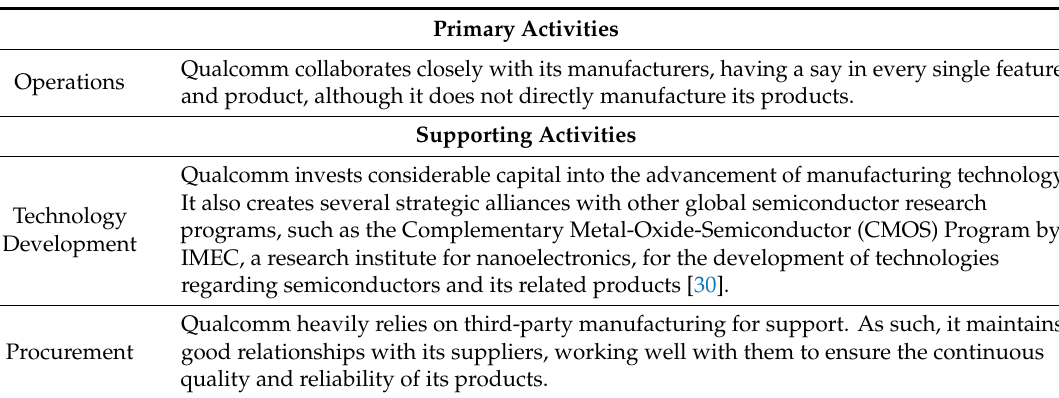
Table 2 highlights the activities in Qualcomm’s fabless model. Table 2. Qualcomm’s Value